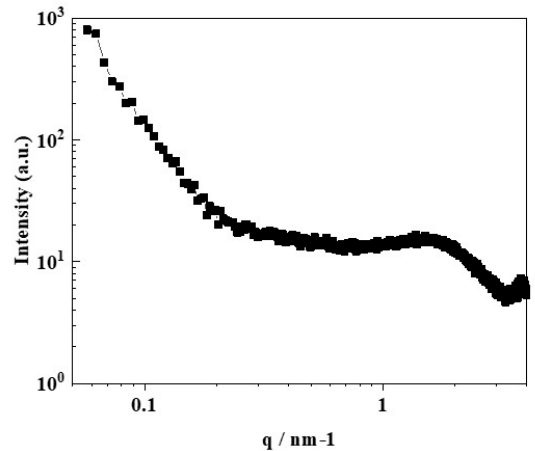
Figure 5. Small angle X-ray scattering (SAXS) profile of a wet-CSPPSU membrane at room temperature.